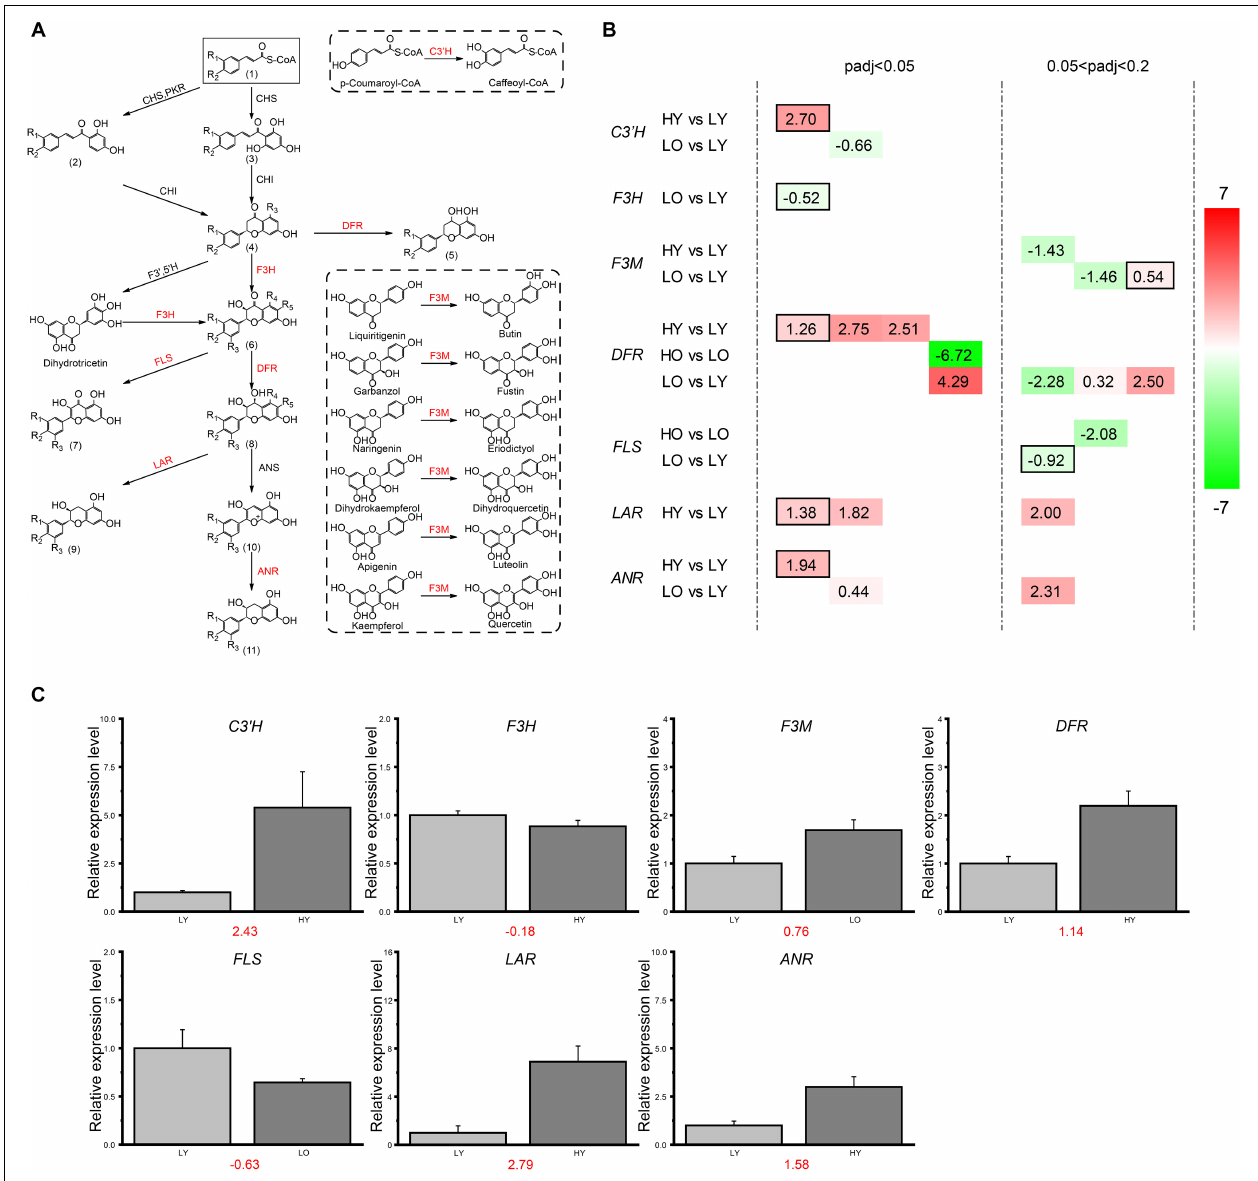
FIGURE 4 | DEGs involved in the flavonoid biosynthesis. (A) The sketch map of the flavonoid biosynthesis pathway. In the flavonoid biosynthesis pathway, the functional enzymes corresponding to the genes screened and defined as DEGs in (B) are marked in red here. R in the chemical structure represents a hydrogen atom or a hydroxyl. (1) Cinnamoyl-CoA; p -Coumaroyl-CoA; Caffeoyl-CoA; (2) Isoliquiritigenin; Butein; (3) Pinocembrin chalcone; Naringenin chalcone; Eriodictyol chalcone; (4) Pinocembrin; Liquiritigenin; Butin; Naringenin; Eriodictyol; (5) Apiforol; Luteoforol; (6) Pinobanksin; Garbanzol; Fustin; Dihydrokaempferol; Dihydroquercetin; Dihydromyricetin; (7) Galangin; Kaempferol; Quercetin; Myricetin; (8) 5-Deoxyleucopelargonidin; 5-Deoxyleucocyanidin; cis -3, 4-Leucopelargonidin; Leucocyanidin; Leucodelphinidin; (9) Afzelechin; ( + )-Catechin; ( + )-Gallocatechin; (10) Pelargonidin; Cyanidin; Delphinidin; (11) (–)-Epiafzelechin; (–)-Epicatechin; (–)-Epigallocatechin. (B) DEGs involved in four comparisons. The different colors correspond to different expression levels with the log 2 (FC) value in each rectangle. For all putative genes, each column means the same unigene. (C) The qRT-PCR results of the key genes involved in flavonoid biosynthesis. The relative expression levels were presented in bar plot with the error bar by calculating the mean and stand deviation (SD) of cDNA copies in three independent replicates. The red numbers under the bar graphs indicated the log 2 (FC) values of each relative expression levels ratio in qRT-PCR. This result held an analogous trend of the transcriptome log 2 (FC) values of the corresponding putative unigenes which held the highest annotation similarity of each gene (black boxed in B ).